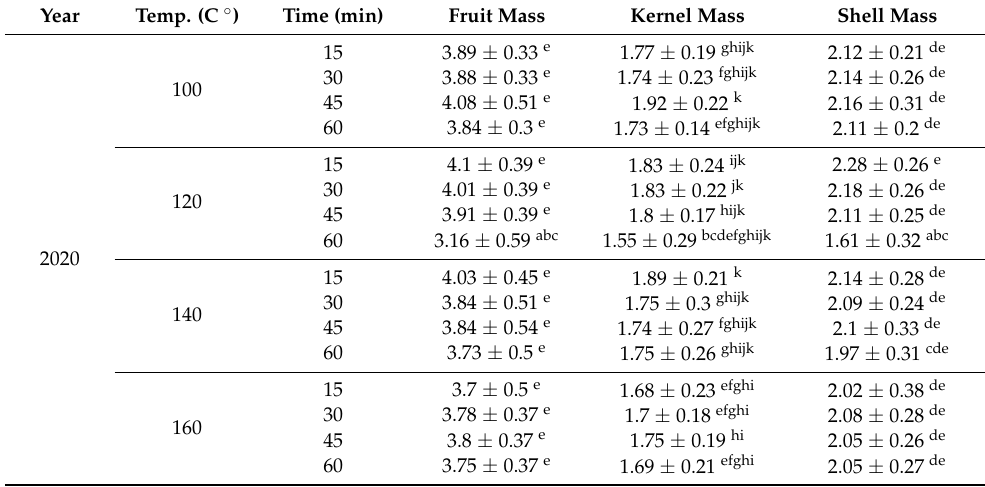
Table 5. Change in mass of hazelnut samples in relation to years of sampling as a function of applied temperatures and drying